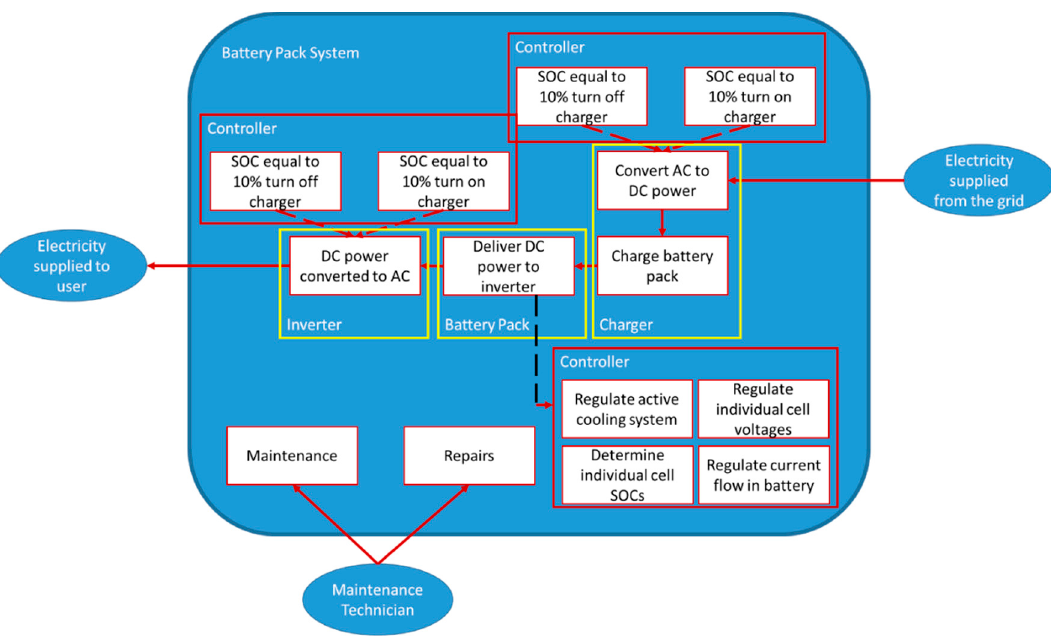
Table 5. Highest risks of design. Rank